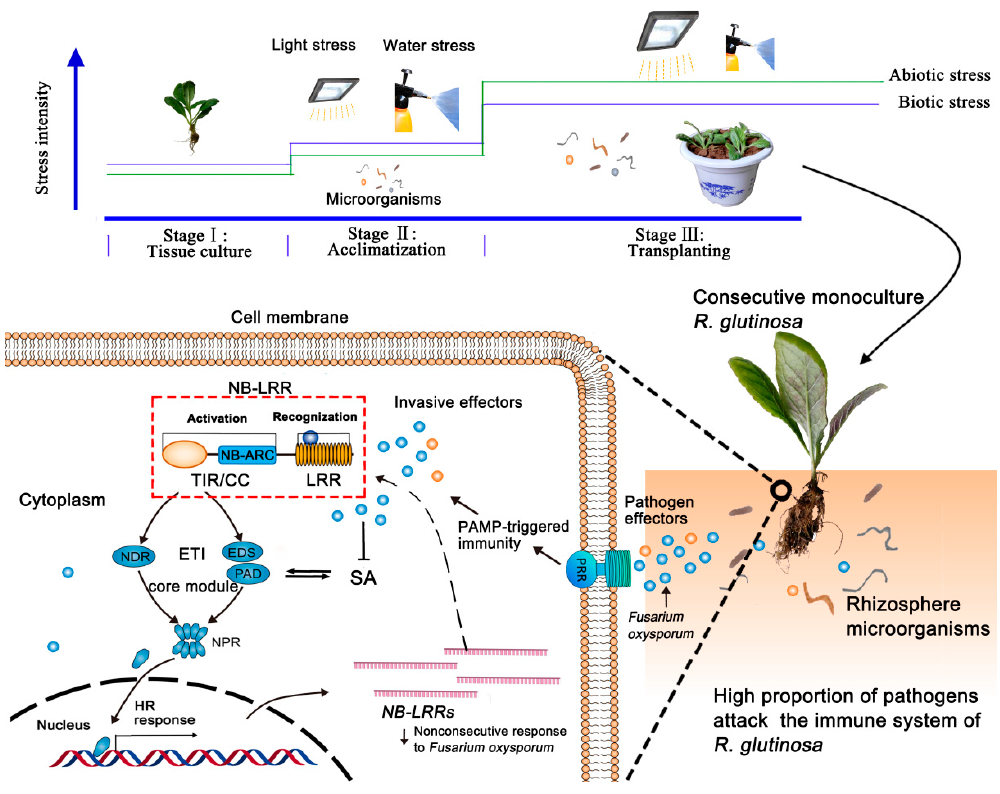
Figure 6. Schematic of effector-triggered immunity response mediated by consecutive monoculture stress in R. glutinosa .